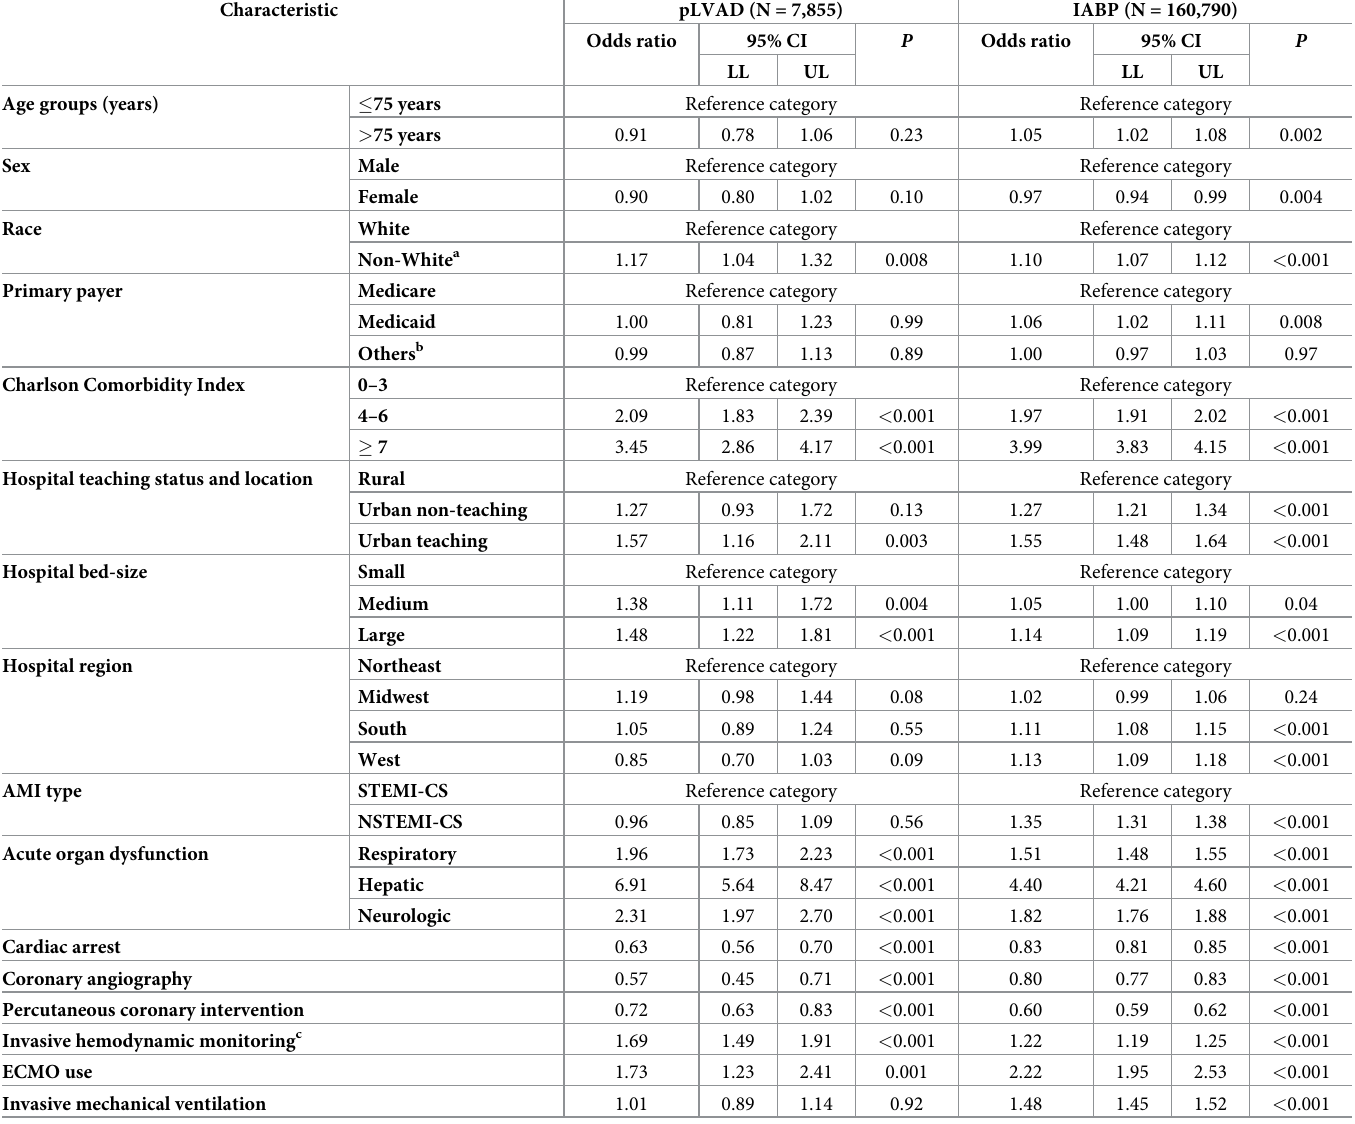
Table 2. Predictors of complications in AMI-CS admissions receiving pLVAD and